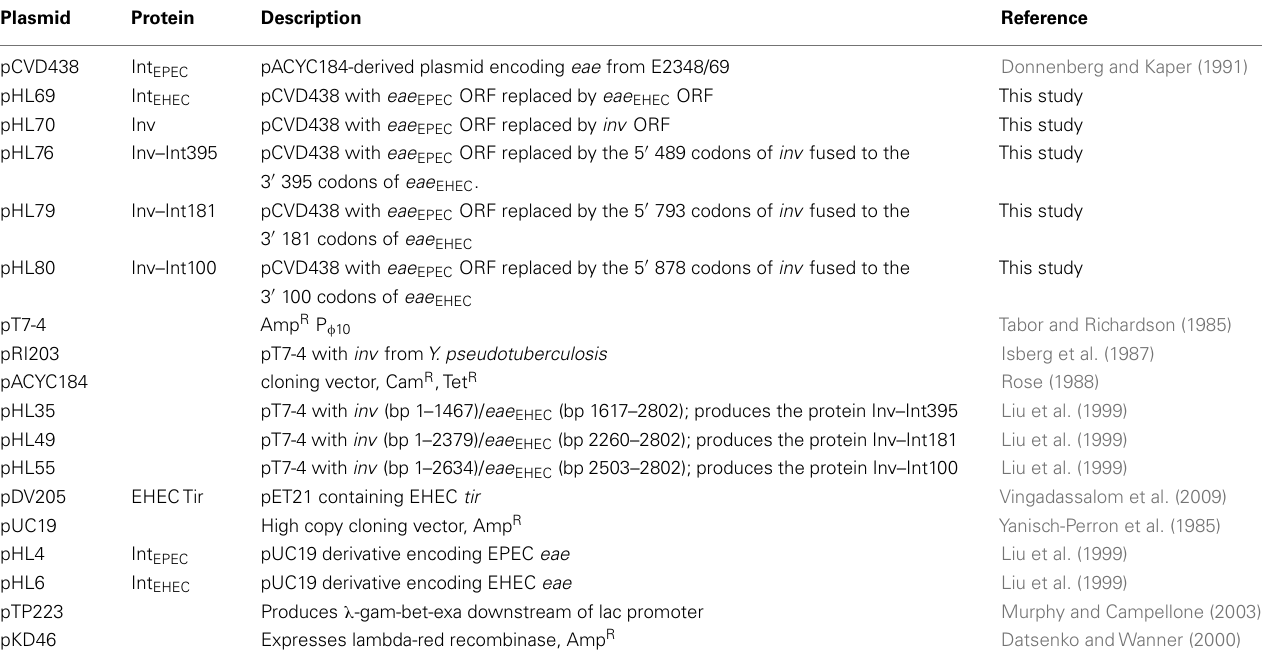
Table 2 | Description of plasmids used in